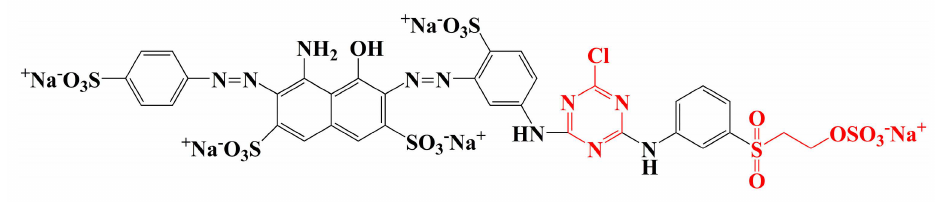
Figure 2. Molecular structure of Reactive Blue